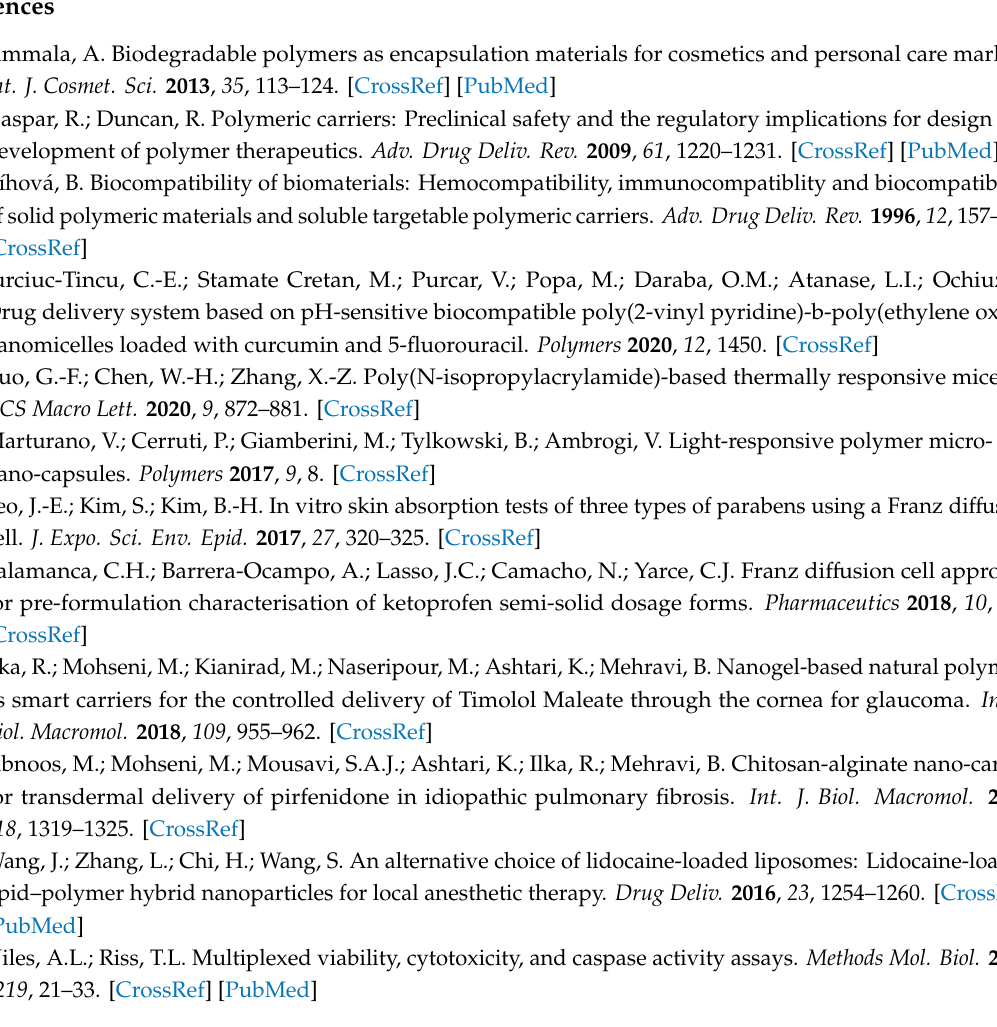
Table S1. Average cell confluence after 72 h. Table S2. NHDF and HaCaT cell cycles after carrier addition at concentrations of 3 µ g / mL or 100 µ g / mL, followed by a 72 h incubation and compared with untreated controls. Table S3. Me45 cell cycles after carrier addition at concentrations of 3 µ g / mL or 100 µ g / mL, followed by a 72 h incubation and compared to untreated controls (CTR). Table S4. Results of Annexin V / PI double staining apoptosis assays in NHDF cells. Table S5. Results of Annexin V / PI double staining apoptosis assay in HaCaT cells. Table S6. Results of Annexin V / PI double staining apoptosis assays in Me45 cells. Figure S1. In vitro carrier cytotoxicity e ff ects on (a) NHDF, (b) HaCaT, (c) Me45, (d) 451-Lu. Figure S2. Confluency increases in (a) Me45, (b) 451-Lu cells treated with compound III (c = 100 µ g / mL). Figure S3. Microscopic visualization of NHDF cell line after senescence